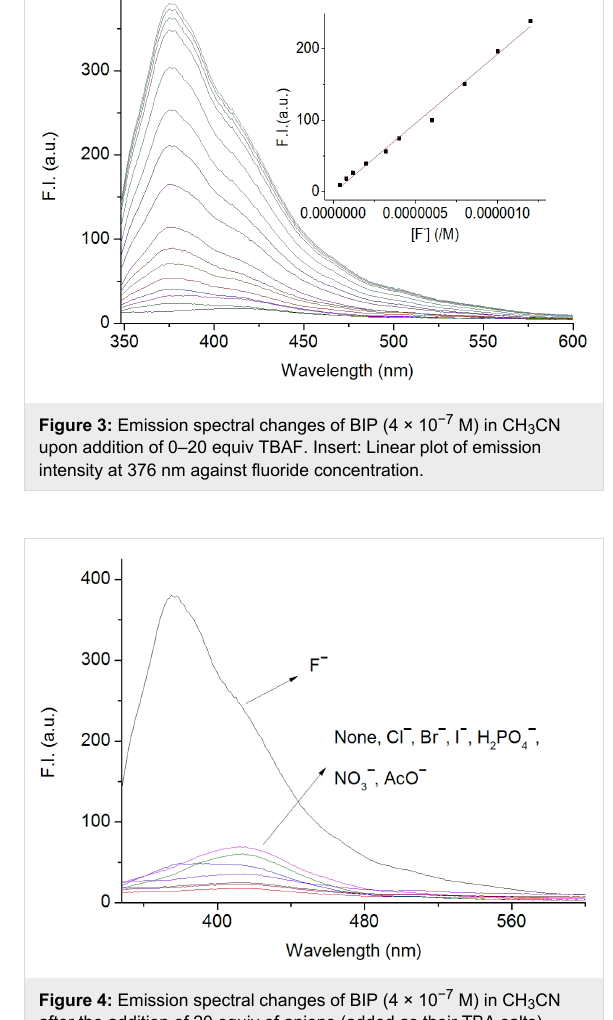
The binding constant of BIP with F − was also determined by nonlinear regression based on spectrofluorometric titration. Good nonlinear curve fits ( R = 0.9907) also indicated the for- mation of an 1:1 stoichiometric complex of BIP with F − (see Figure S2 in Supporting Information File 1). The association constant was 8.79 × 10 5 M − 1 , which was bigger than that obtained from UV–vis spectroscopy. This suggested the enhancement of the phenolic OH acidity by the photoexcitation [2,11-15]. Moreover, fluoride-dependent fluorescent intensity at 376 nm displayed an excellent linearity ( R = 0.9880) in the concentration range of 0.04–1.2 μ M (insert Figure 3 and Figure S3 in Supporting Information File 1). The limit of detection for F − was found to be 0.021 μ M, which is lower than 0.10 μ M set by the US Environmental Protection Agency. This suggested that BIP had a good sensitivity for fluoride and has the poten- tial utility to detect